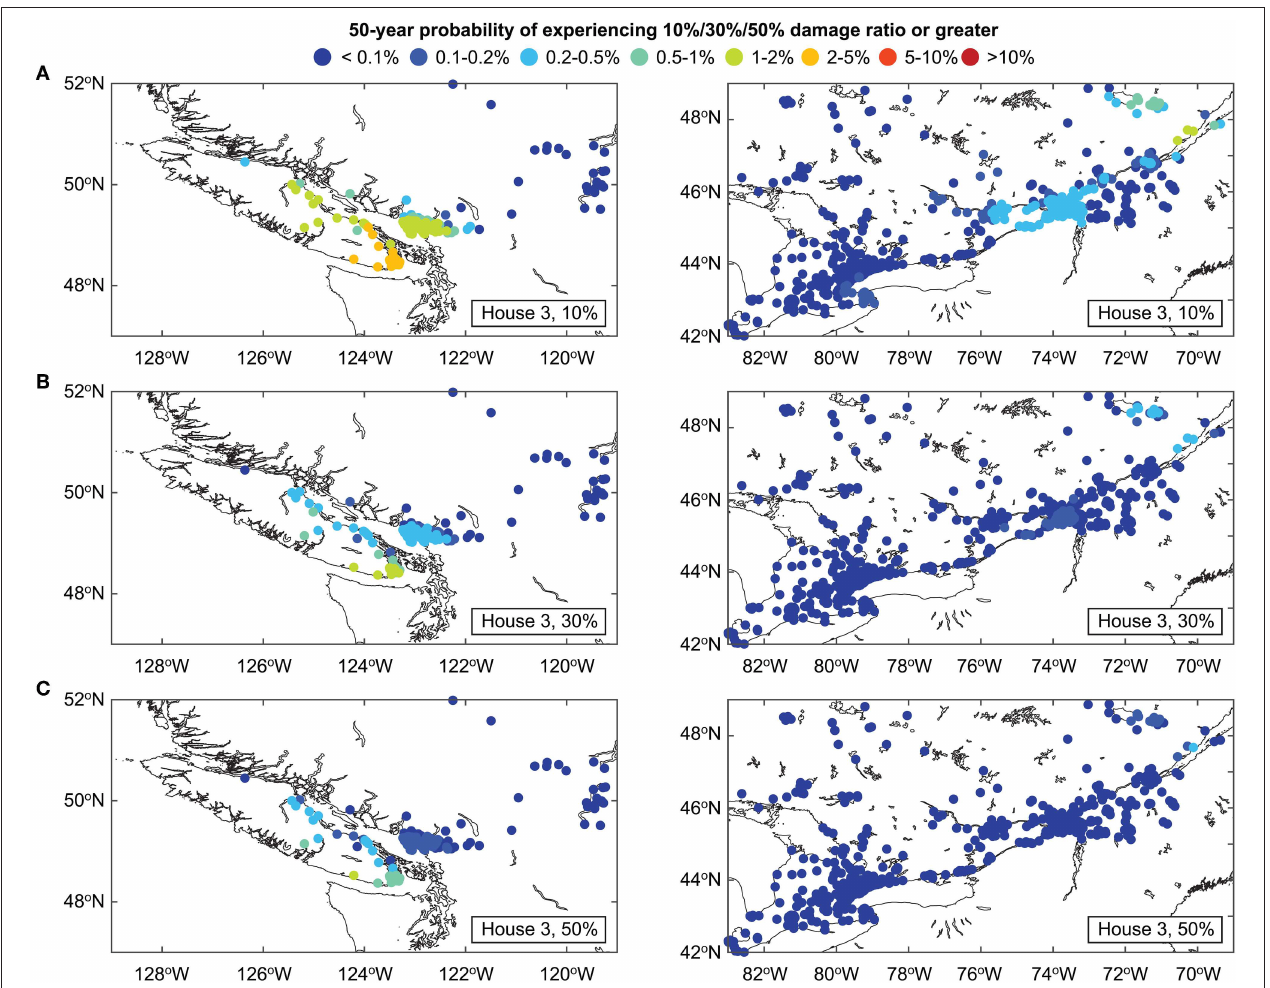
FIGURE 14 | Seismic risk maps in terms of 50-year probability of experiencing certain damage thresholds for House 3 in western and eastern Canada: (A) 0.1 damage ratio or greater, (B) 0.3 damage ratio or greater, and (C) 0.5 damage ratio or greater.